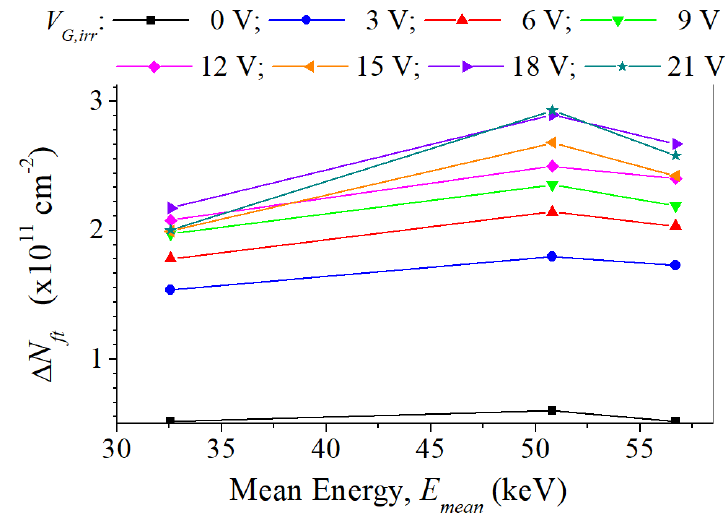
Figure 7. ∆ N st at K air = 50 Gy versus gate voltage during irradiation .